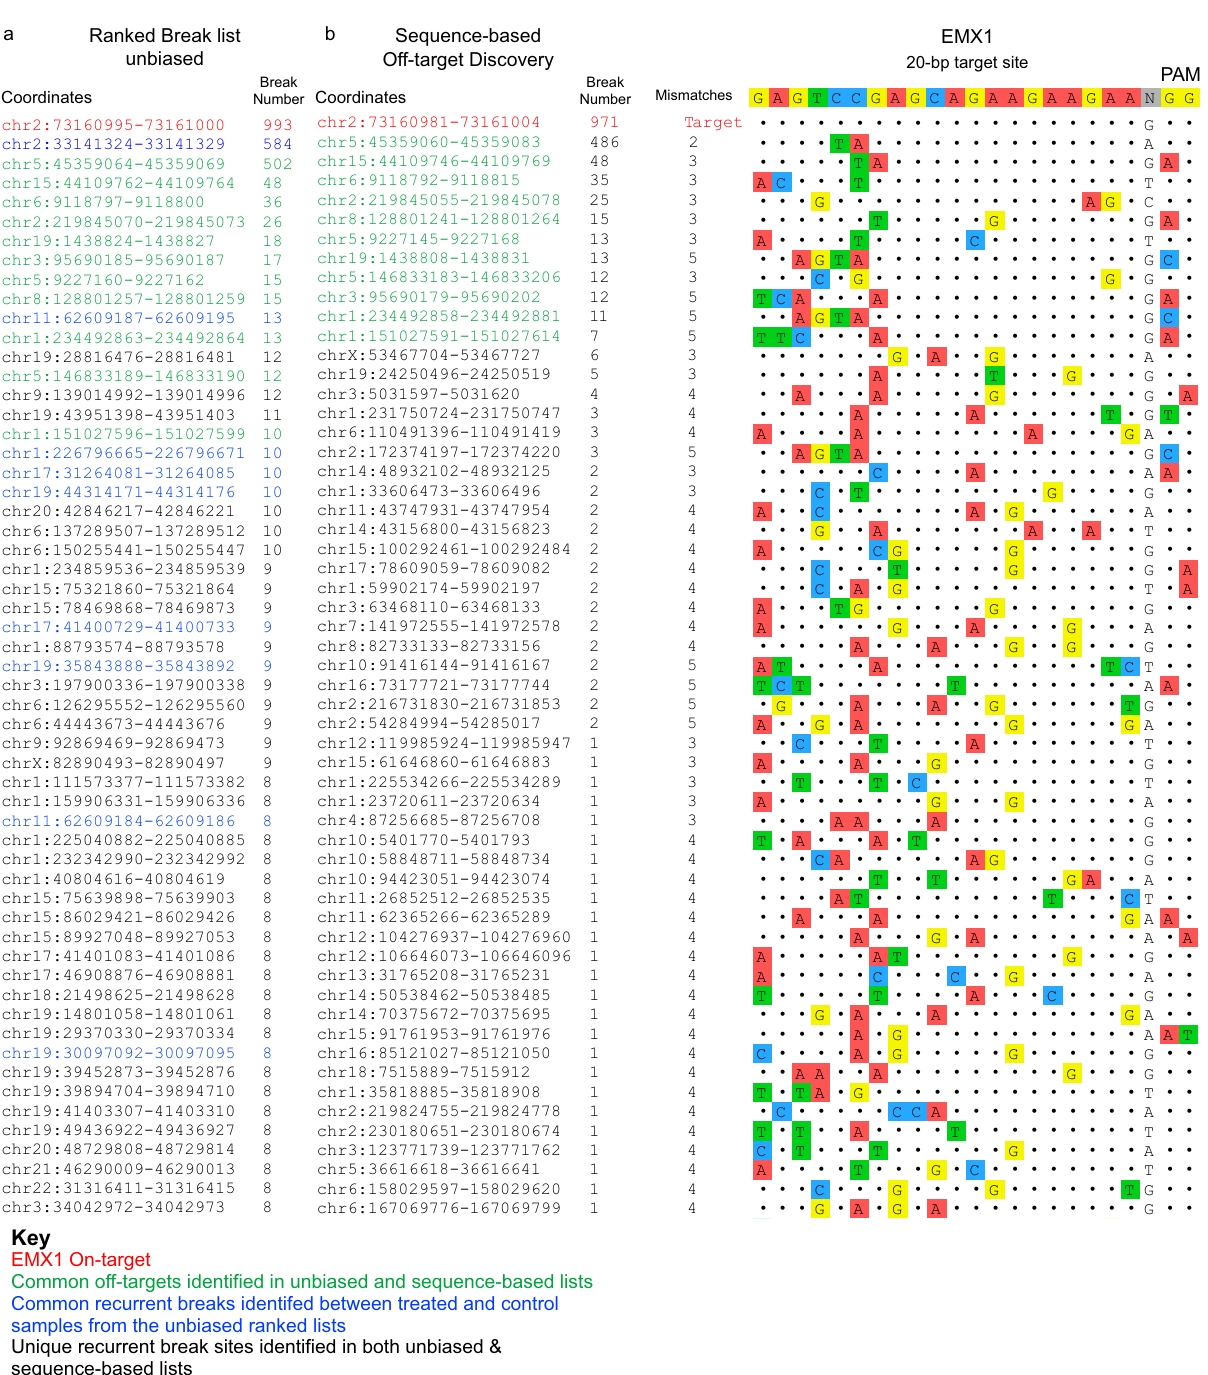
EMX1 On-target Common off-targets identified in unbiased and sequence-based lists Common recurrent breaks identifed between treated and control samples from the unbiased ranked lists Unique recurrent break sites identified in both unbiased & sequence-based Fig. 4 INDUCE-seq sensitively discovers and quanti fi es CRISPR-Cas9 induced on- and off-target DSBs in the genome. a A ranked list of recurrent DSBs from the EMX1 gene-edited data. The on-target is highlighted in red, while the recurrent breaks common to both treated and untreated control sample are highlighted in blue. The recurrent breaks common to both the rank-based list and the sequence-based off-target discovery list are highlighted in green. b Sequence-based off-target discovery list. ( b , left panel) On- and multiple off-target sequences and the number of breaks identi fi ed using INDUCE-seq for the EMX1 sgRNA. ( b , right panel) Mismatching bases from the target sequence are highlighted and colour coded. Source data are provided as a Source Data fi le. results in a higher rate of false discovery and vice versa. This mismatch plot, highlighting mismatches from the EMX1 target explains the selection of fi lter condition 7 as being optimal for the sequence shown in colour. discovery of editing induced breaks by EMX1 during genome Next, we compared the kinetics of break induction during editing in this example. Optimal fi lter selection will be guide- and EMX1 gene editing across 5 time points. Figure 5a and cell-type dependent. Figure 4b, right panel presents the off-target Supplementary Fig. 6b and d show that the majority of both